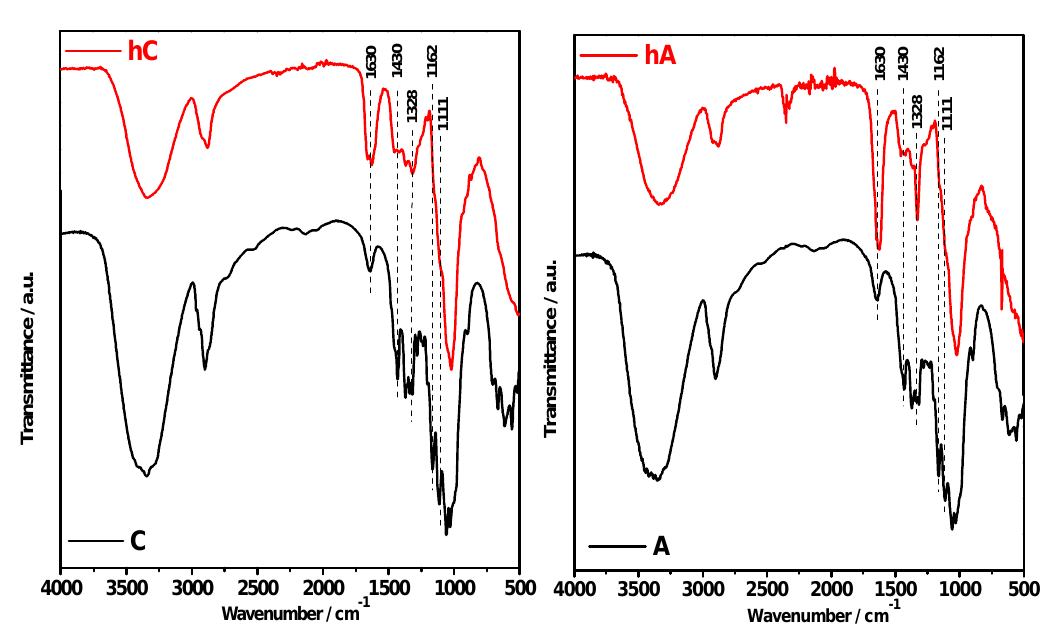
Figure 1. FTIR spectra of the C and A starting celluloses compared with their hydrogels (hC and hA,